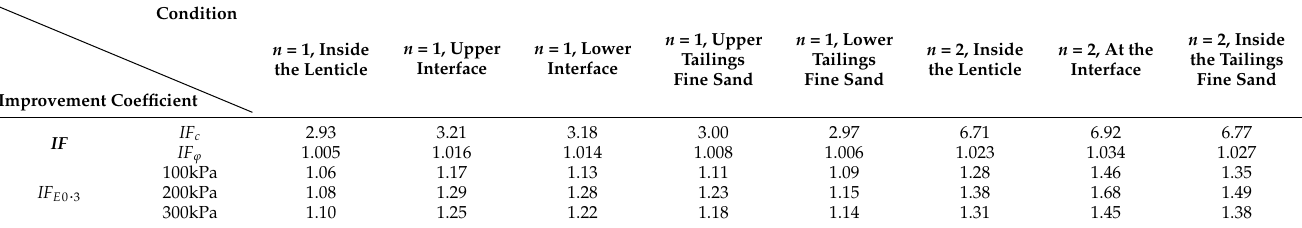
Table 6. Strength improvement coefficient of tailings under different reinforcement